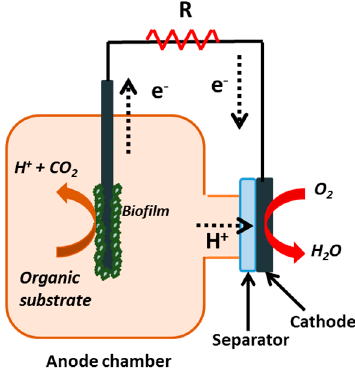
Figure 1. Schematic representation of a microbial fuel cell (MFC).